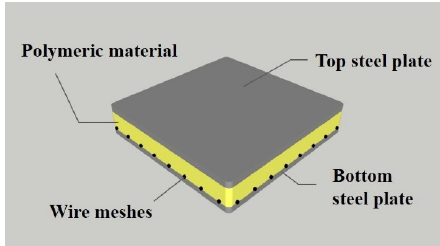
Figure 1. Components of the hybrid floor.